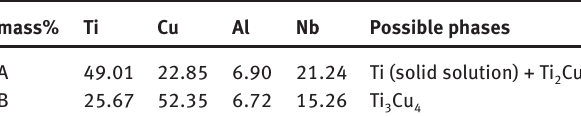
Table 3: Chemical analysis results of joints produced at 1223 K × 30 min